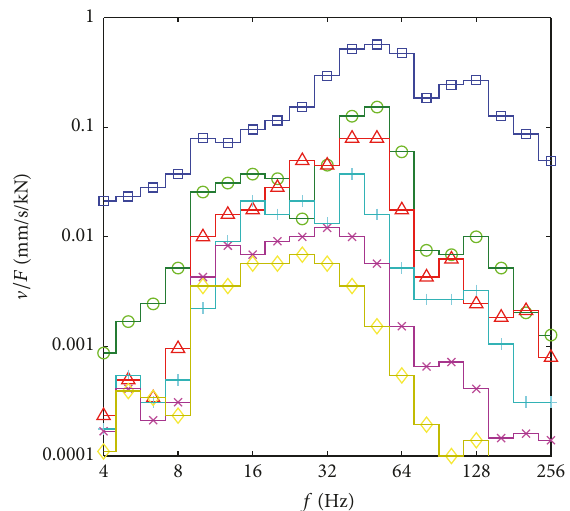
Figure 6: Transfer function of the soil and one-third of octave band spectra of the mobility at the distances ◻ 2.5, I 7.5, △ 12.5, + 22.5, × 37.5, and ◊ 62.5 m.